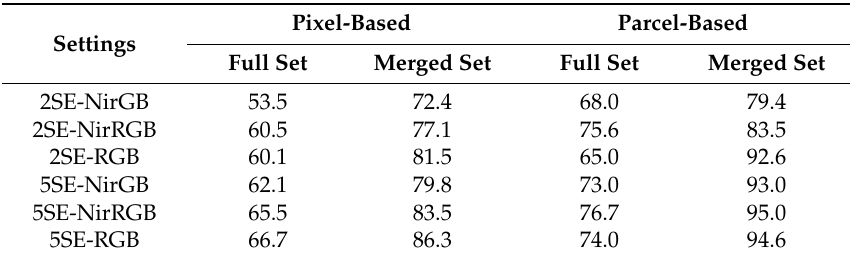
Table 5. OA (%) for all settings, spatial supports and sets of crop classes at 0.5 m spatial resolution.